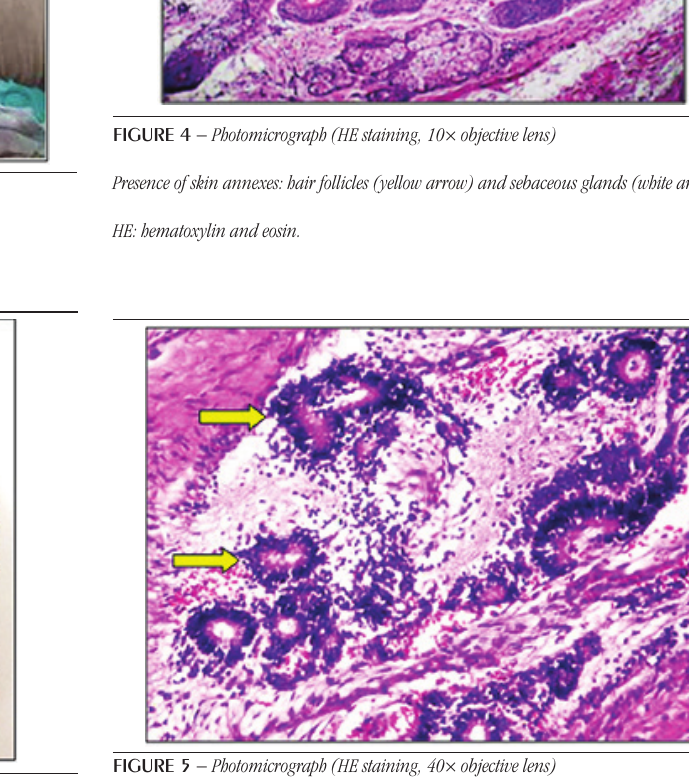
figuRE 3 − External surface and cut surface of the tumor Bosselated external surface (in the insert) and cut surface of the mass with solid cartilaginous (white arrow) and cystic (yellow arrows) areas.